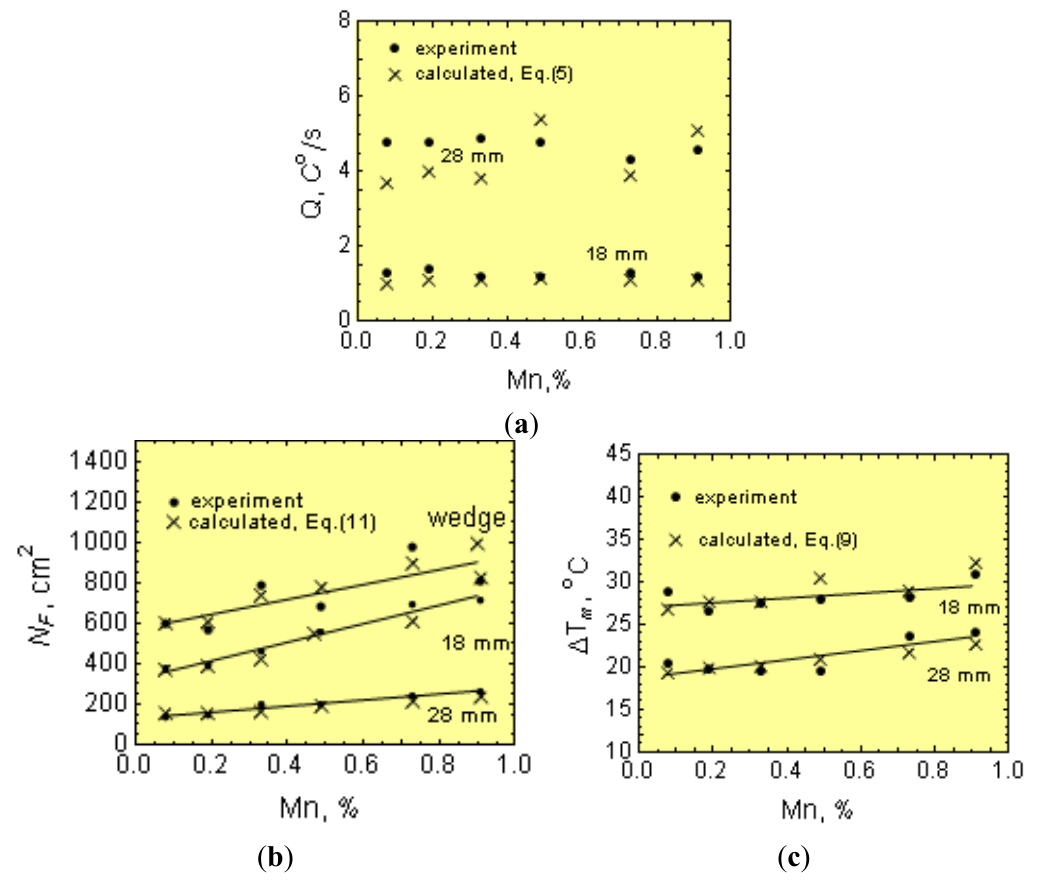
Figure 16. Effect of manganese on ( a ) Q, ( b ) N F and ( c ) Δ T m